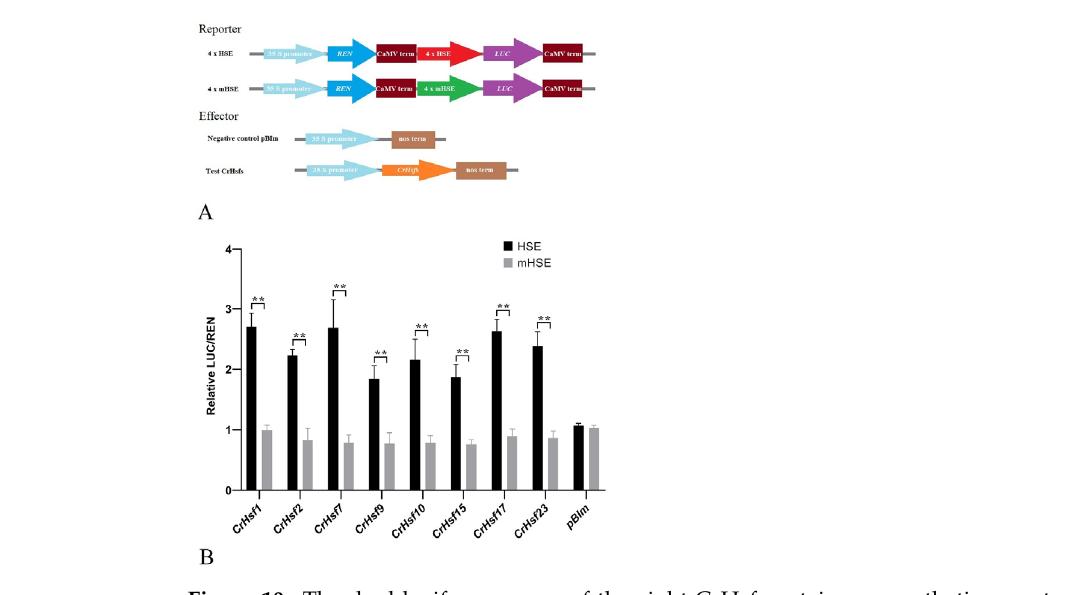
Figure 10. The dual-luciferase assay of the eight CrHsf proteins on synthetic reporter plasmids (4 × GAAACTTC (HSE)-pGreenII0800-LUC or 4 × GACACACT (mHSE)-pGreenII0800-LUC): ( A ) The schematic diagram of the constructs. REN, Renilla luciferase; LUC, firefly luciferase; terM, terminator; ( B ) the ratio of LUC/REN activity in Nicotiana benthamiana mesophyll cells co-transfected with agrobacterium GV3101 containing different LUC reporters (HSE or mHSE) and REN effectors (different CrHsfs and pBIm for testing or empty vector pBIm as negative control). ** The values are means ± SD of three biological